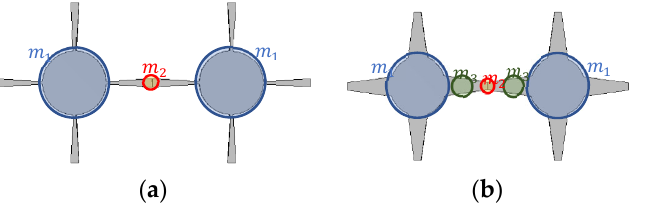
Figure 7. The distribution of mass along the periodic structure with various angles of trapezoidal arms: ( a ) θ = − 1.5 ◦ ; ( b ) θ = + 8 ◦ .